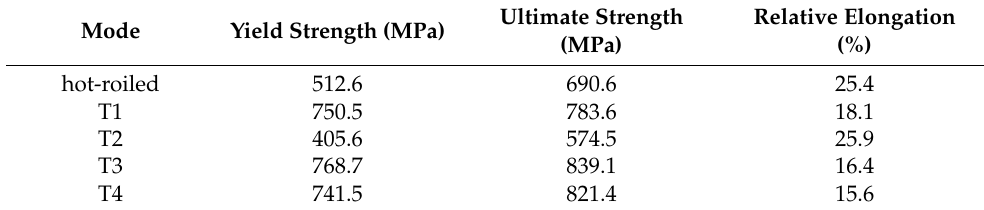
Table 3. Mechanical properties of steel under static loading.